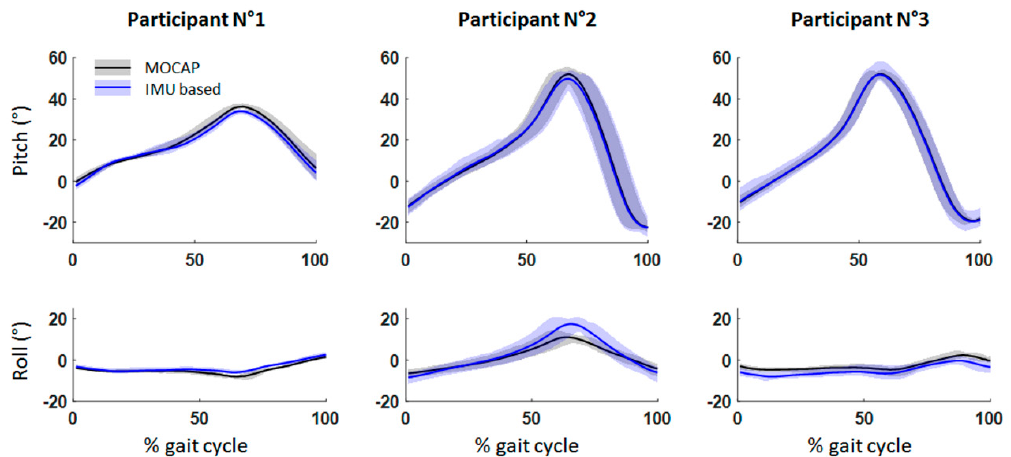
Figure 5. Attitudes obtained from the motion capture (MOCAP) system (black) and the IMU (blue). The mean curve (solid line) and the envelope containing all curves are shown for each participant. Table 3. Attitude estimation for each participant (mean(min/max)). The roll and pitch angles are in the frontal and sagittal planes respectively.